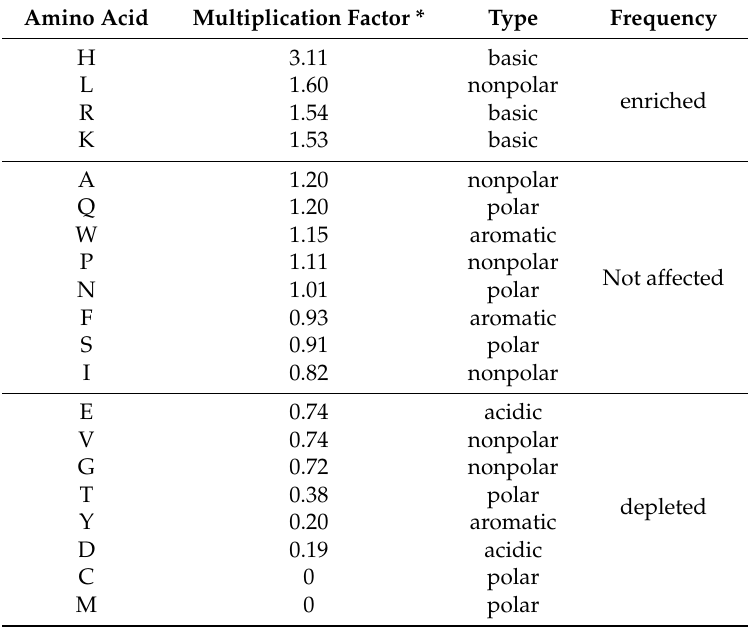
Table 2. Amino acid frequencies in SnO-binding peptides, compared to the native peptide library. Amino Acid Multiplication Factor *